Question: Summarize what this figure shows in one sentence.
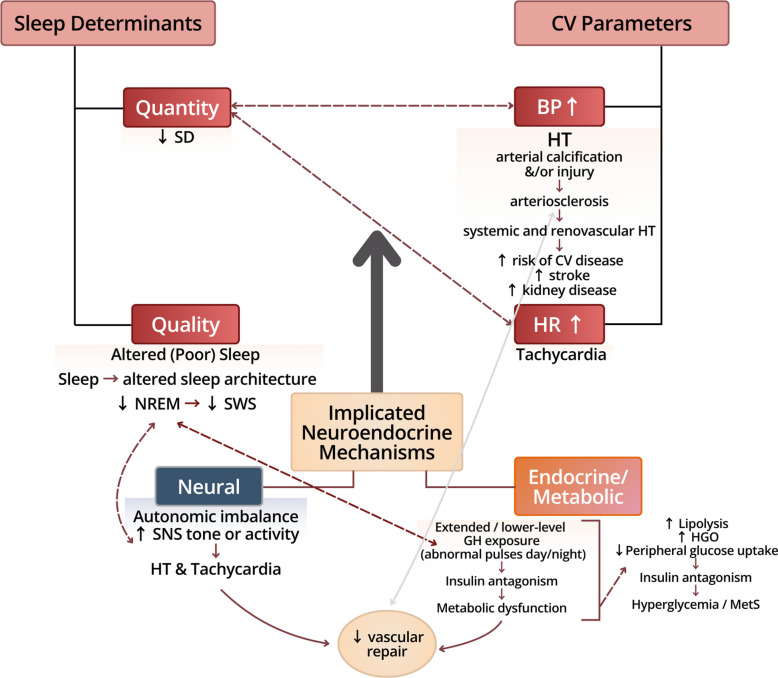
Answer: Schematic representation of sleep-cardiovascular interactions mediated by neuroendocrine mechanisms. Reduced sleep duration and poor sleep quality, particularly decreased N3 (slow-wave sleep), contribute to autonomic imbalance characterized by increased sympathetic nervous system activity, leading to hypertension and tachycardia. Concurrently, endocrine and metabolic alterations, including elevated cortisol levels, reduced growth hormone secretion, and insulin resistance with impaired glucose metabolism, are associated with metabolic dysfunction and hyperglycemia. These processes converge to induce endothelial dysfunction, impair vascular repair mechanisms, and are associated with athero-/arterio-sclerosis and myocardial remodeling. Collectively, these effects increase the risk and morbidity associated with systemic and renovascular hypertension, stroke, chronic kidney disease, and other cardiovascular complications. BP , blood pressure; CV , cardiovascular; GH , growth hormone; HGO , hepatic glucose output; HR , heart rate; HT , hypertension; MetS , metabolic syndrome; SD , sleep duration; SNS , sympathetic nervous system